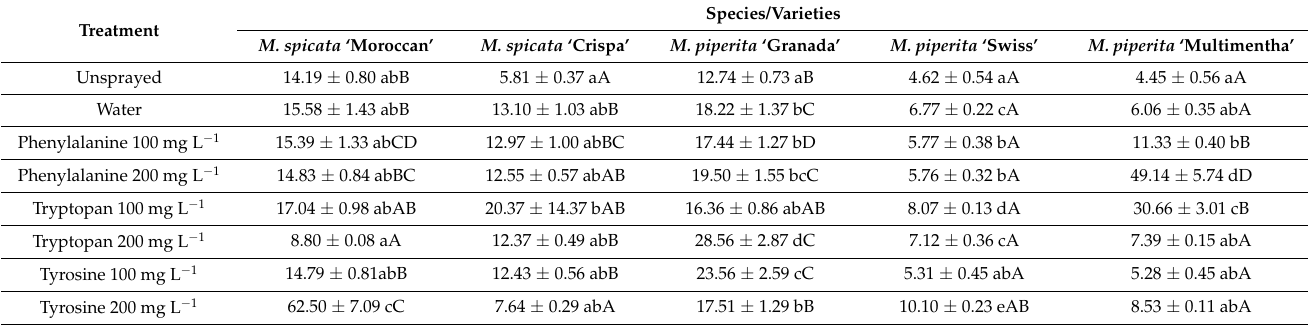
Table 7. Kaempferol content in mint influenced by foliar application of amino acids, mg 100 g − 1 DM in